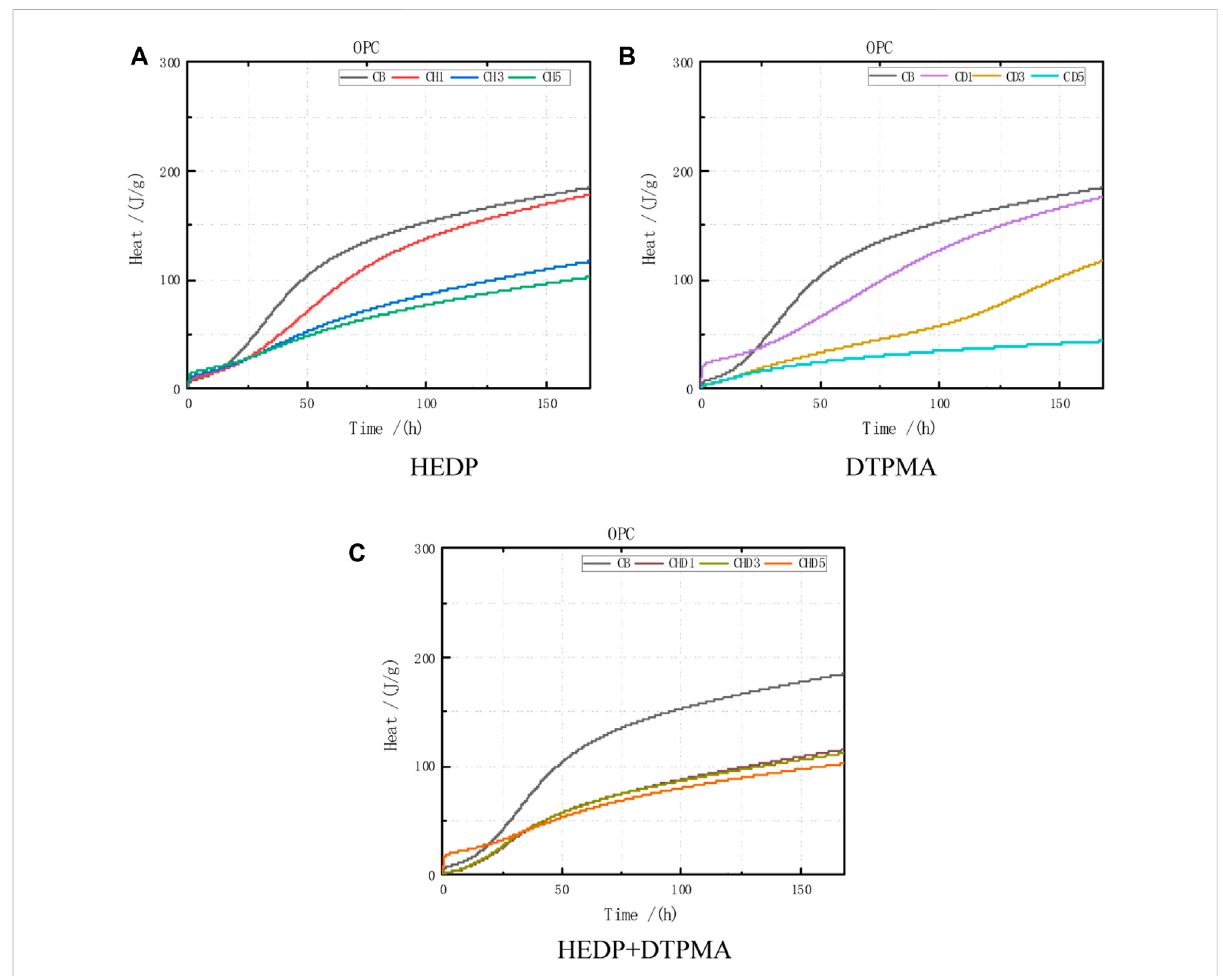
FIGURE 8 Heat of hydration data obtained from OPC combined with the following: (A) HEDP, (B) DTPMA, and (C) HEDP + DTPMA.